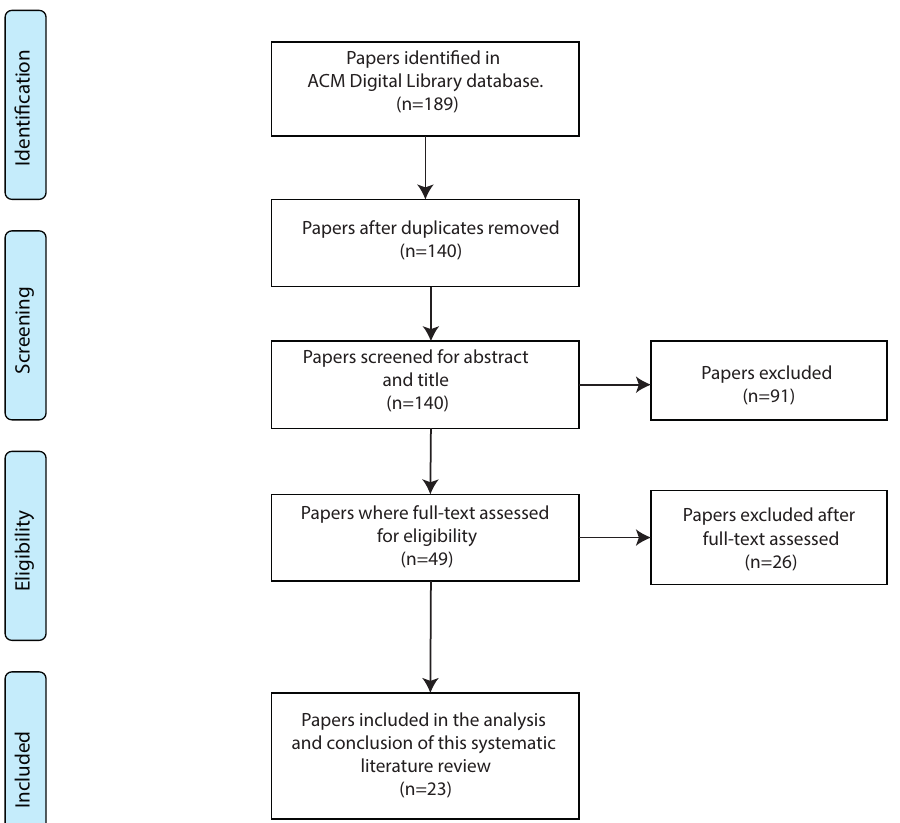
Figure 1. Systematic literature review flow diagram, following the PRISMA guidelines.